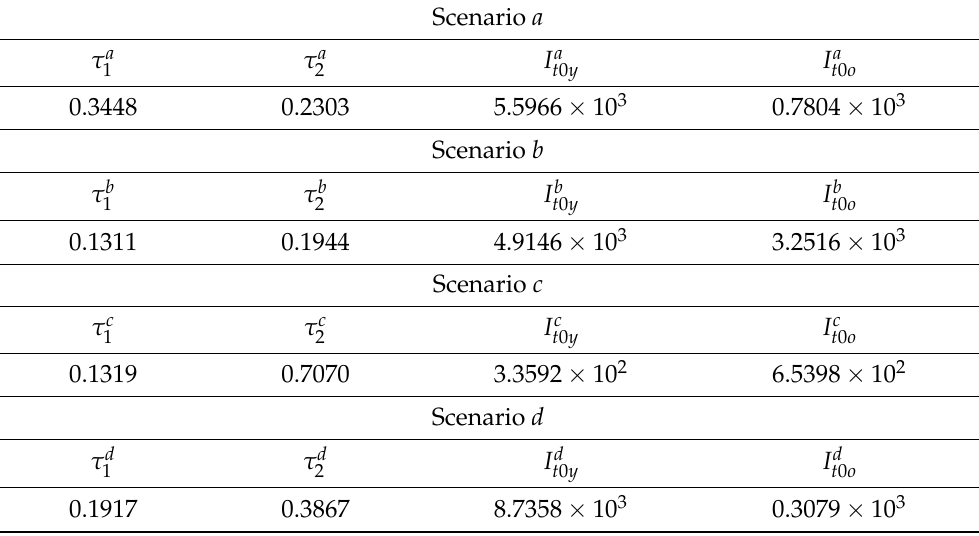
, I i in the different scenarios i ∈ { a , . . . , f } t 0 y t 0 o as average time for disease 2 for the initial old subjects t 0 o